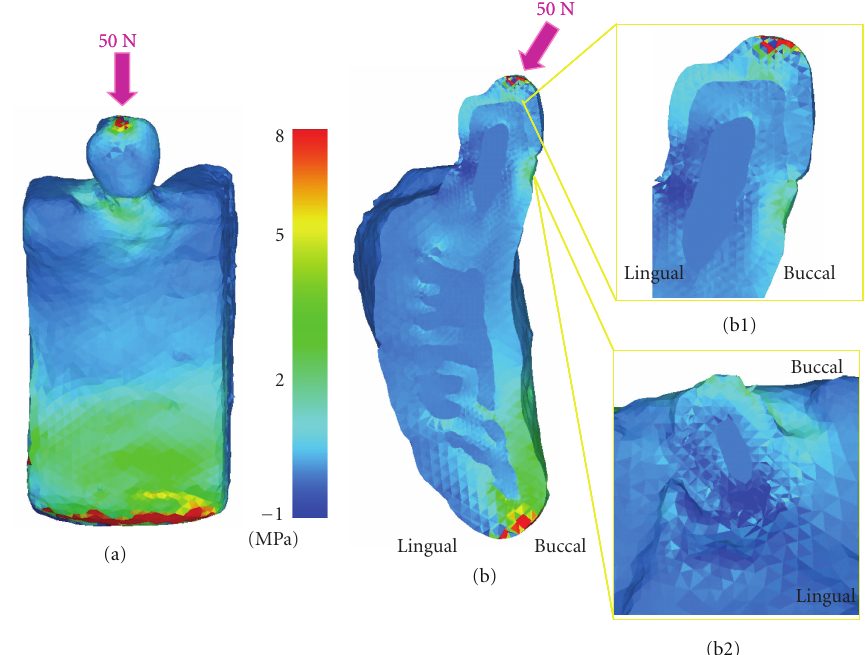
Figure 4: Maximum principal stress distribution. (a) Buccal view, (b) Buccolingual cross-section, (b1) Magnify of Buccolingual cross- section, (b2) Magnify of horizontal cross-section at the